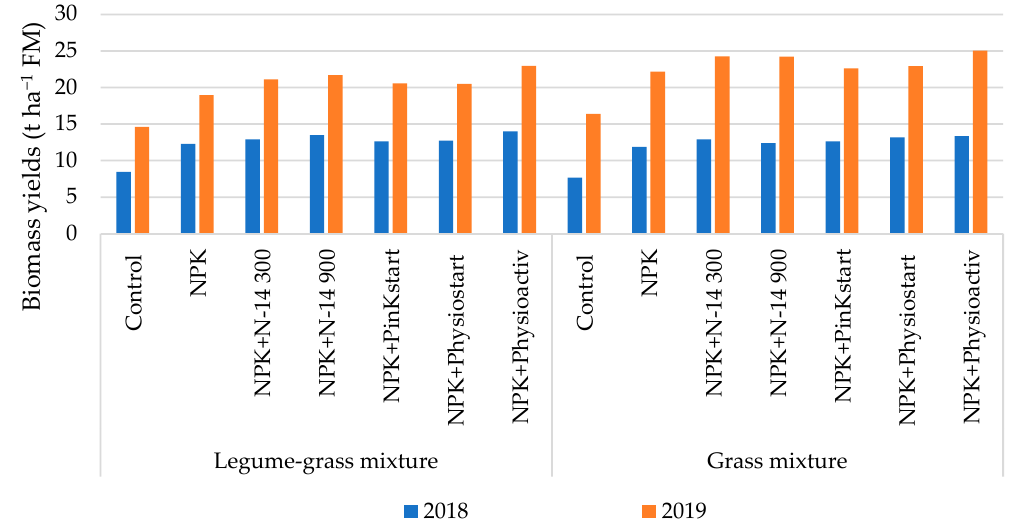
Figure 4. Biomass yields of legume-grass mixture (LGM) and grass mixture (GM) in 2018 and 2019 (t·ha − 1 FM).